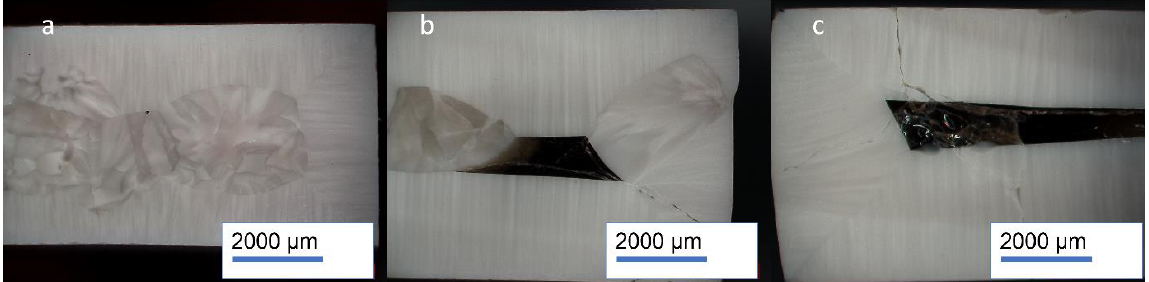
Figure 12. Optical microscope images of samples of parent glass C3 heat treated at 850 ◦ C for 20 h ( a ), 900 ◦ C for 2 h ( b ) and 950 ◦ C for 0.5 h ( c ).